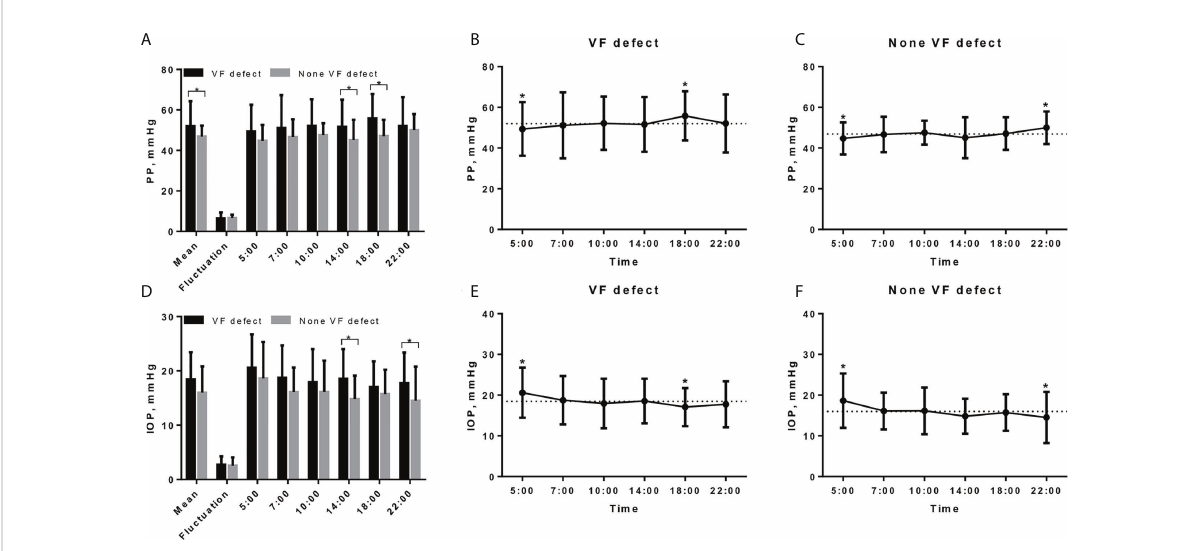
FIGURE 2 Diurnal rhythm of pulse pressure and IOP in TAO patients with and without VF defect. (A) Diurnal rhythm of PP in TAO patients with and without VF defect, * indicated signi fi cant difference between two groups. (B) Diurnal rhythm of PP in TAO patients with VF defect, dashed line indicates the mean PP value (52.06 mmHg) and * indicates the signi fi cant difference between PP value at that measurement point and mean value. (C) Diurnal rhythm of PP in TAO patients without VF defect, dashed line indicates the mean PP value (46.87 mmHg) and * indicates the signi fi cant difference between PP value at that measurement point and mean value. (D) Diurnal rhythm of IOP in TAO patients with and without VF defect, * indicates signi fi cant difference between two groups. (E) Diurnal rhythm of IOP in TAO patients with VF defect, dashed line indicates the mean IOP value (18.44 mmHg) and * indicates the signi fi cant difference between IOP value at that measurement point and mean value. (F) Diurnal rhythm of IOP in TAO patients without VF defect; dashed line indicates the mean PP value (15.99 mmHg) and * indicates the signi fi cant difference between PP value at that measurement point and mean value. PP, pulse pressure; IOP, intraocular pressure; VF, visual fi eld.